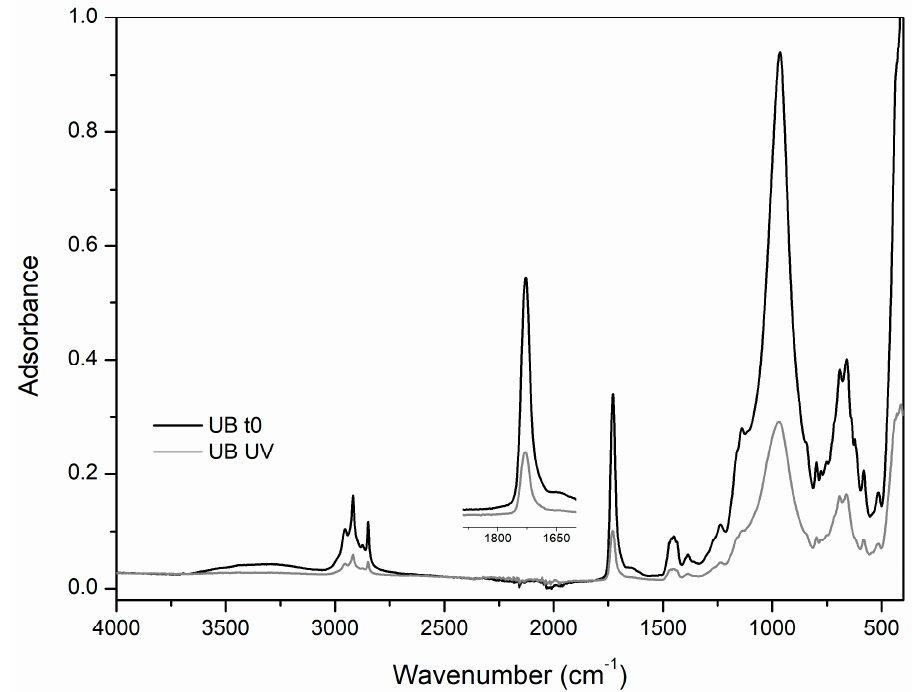
Figure 7. FT-IR-ATR spectra of ultramarine blue mock-ups before ageing (t0) and after UV ageing procedure (UV).